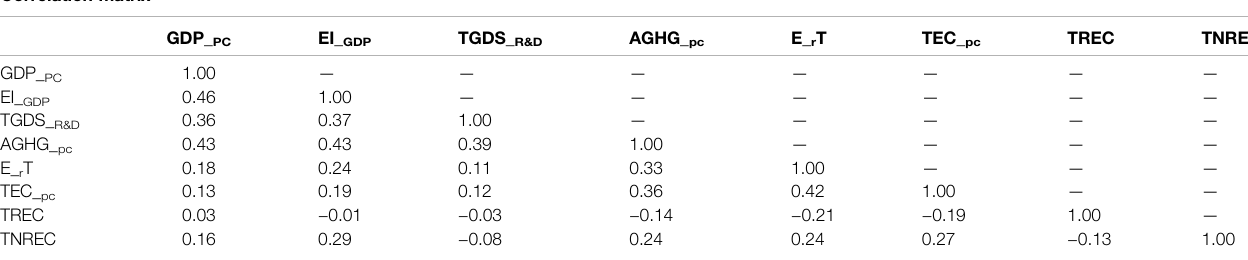
TABLE 2 | Results of the pairwise correlation matrix. Correlation